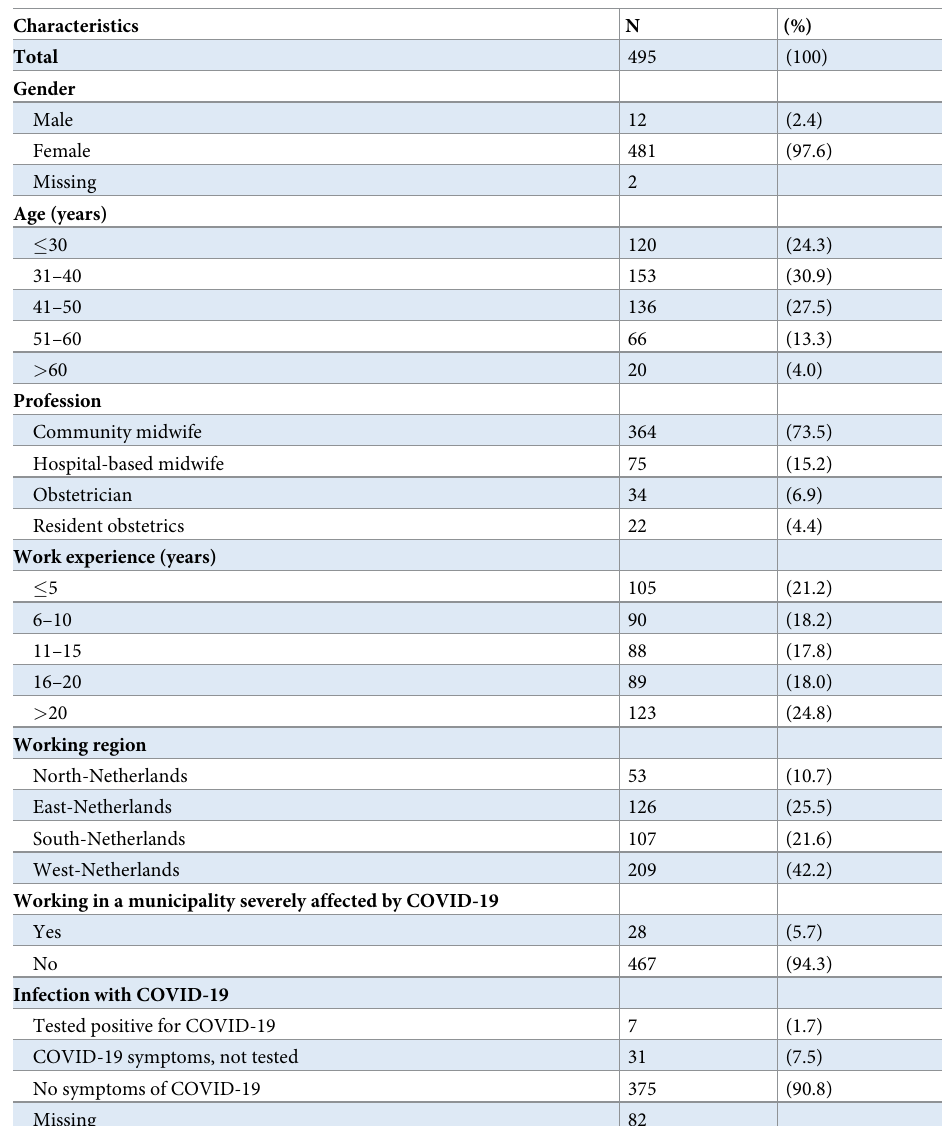
Table 1. Characteristics of the study population.